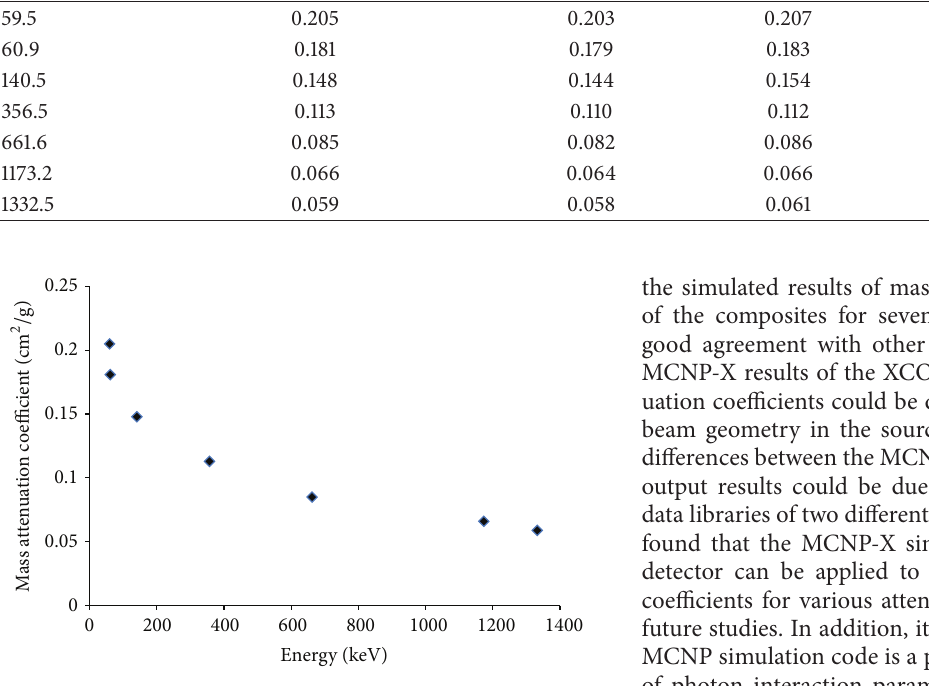
Figure 5: Calculated mass attenuation coefficients of concrete sample by MCNP-X.